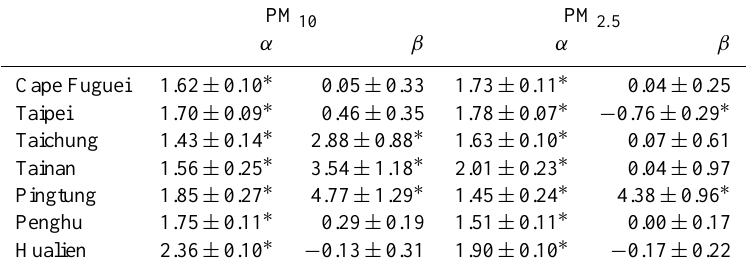
Table 1. Summary of linear regression for the relationship between primary organic carbon and elemental carbon (POC= α *EC+ β) .